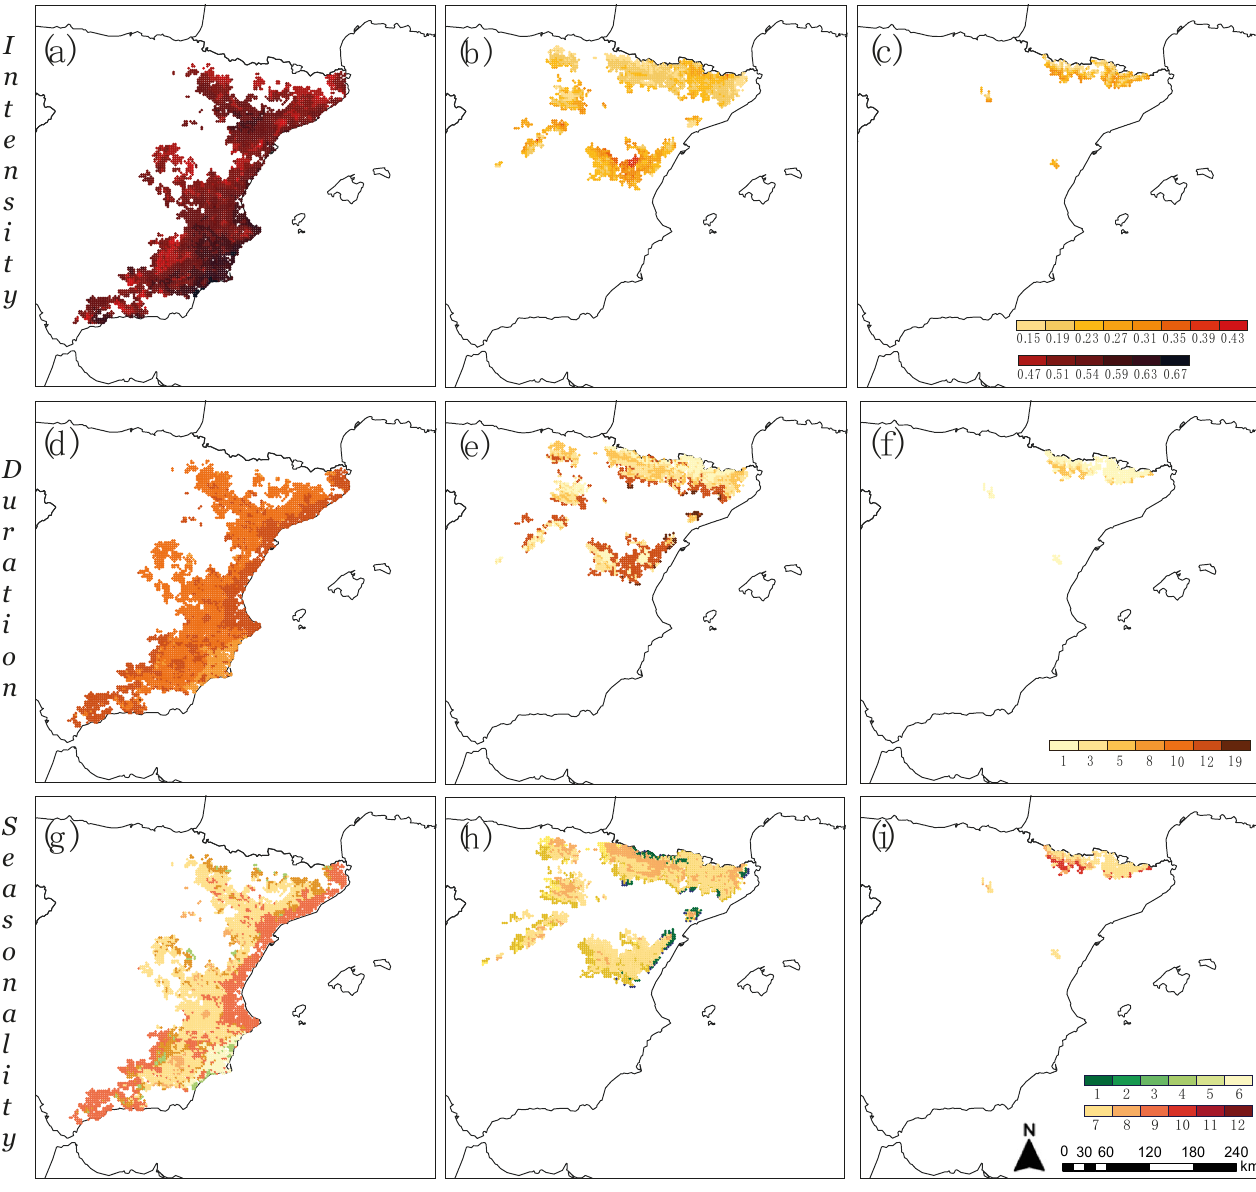
Figure 4. Predicted intensity, duration (in months), and seasonality (in months) of drought effects on P. halepensis ( a , d , g ), P. sylvestris ( b , e , h ), and P. uncinata ( c , f , i ) based on the current distribution of each species.